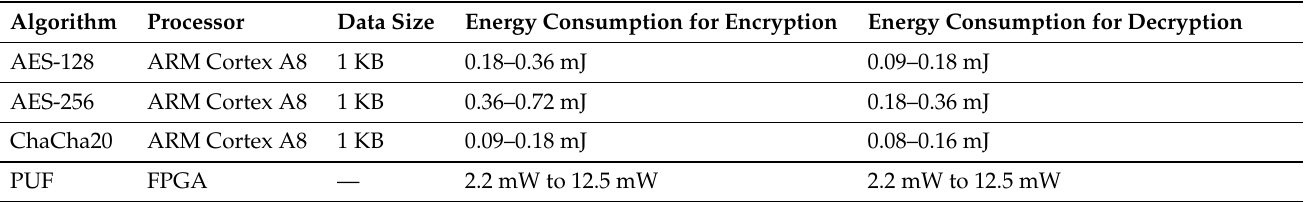
Table 2. Comparison of energy consumption [49,50].